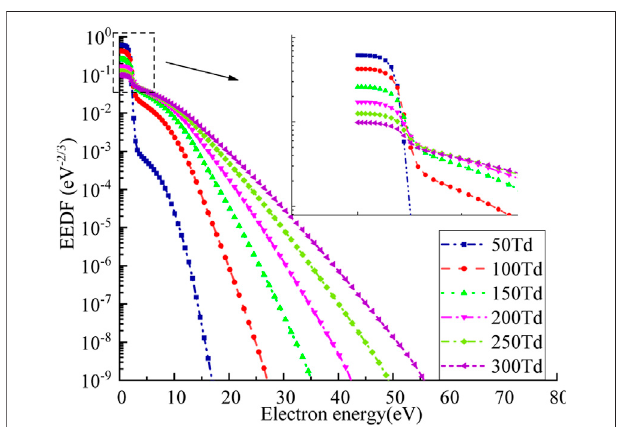
FIGURE 1 | Electron energy distribution function (EEDF) distribution of dry air.